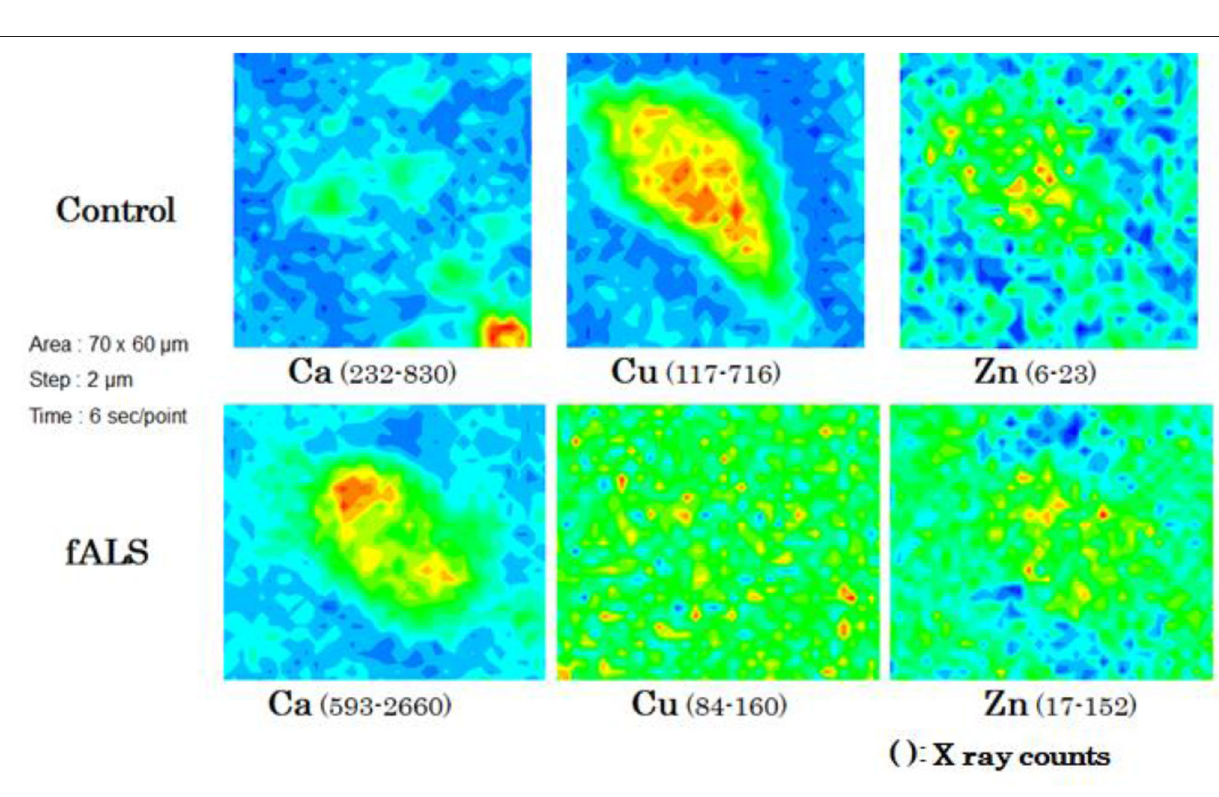
extremely low, whereas the Zn contents were extremely high, as compared to those of the sALS cases and the